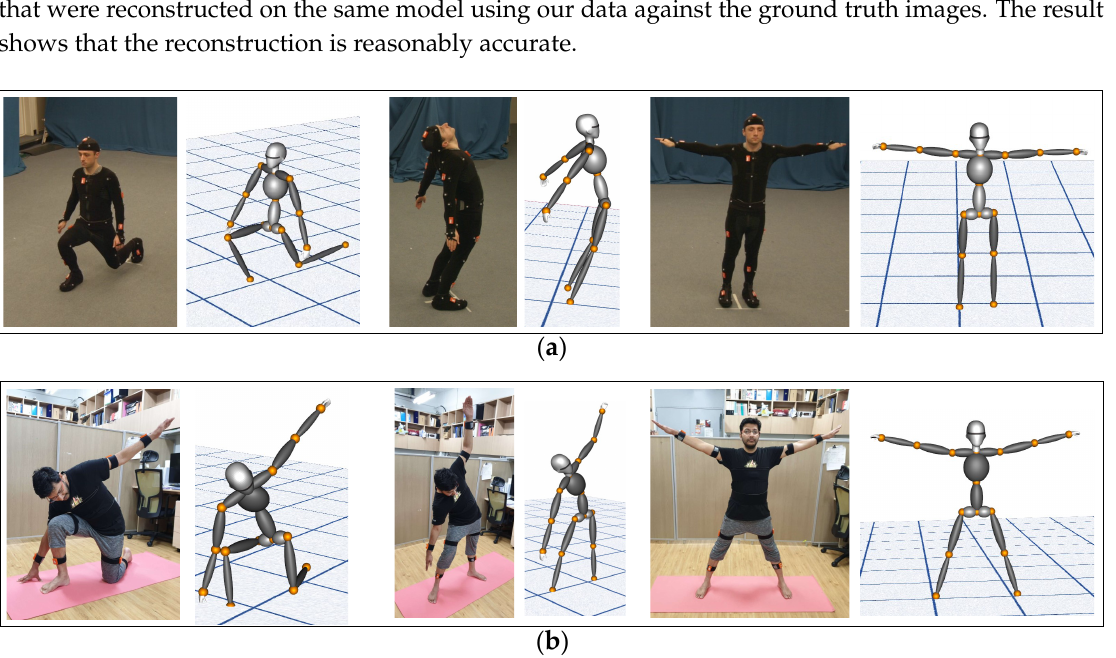
Figure 11. Validation of the motion reconstruction with our 3D Avatar: ( a ) Reconstruction of the TotalCapture Range of Motion (Subject 1) data ( b ) Reconstruction of our user